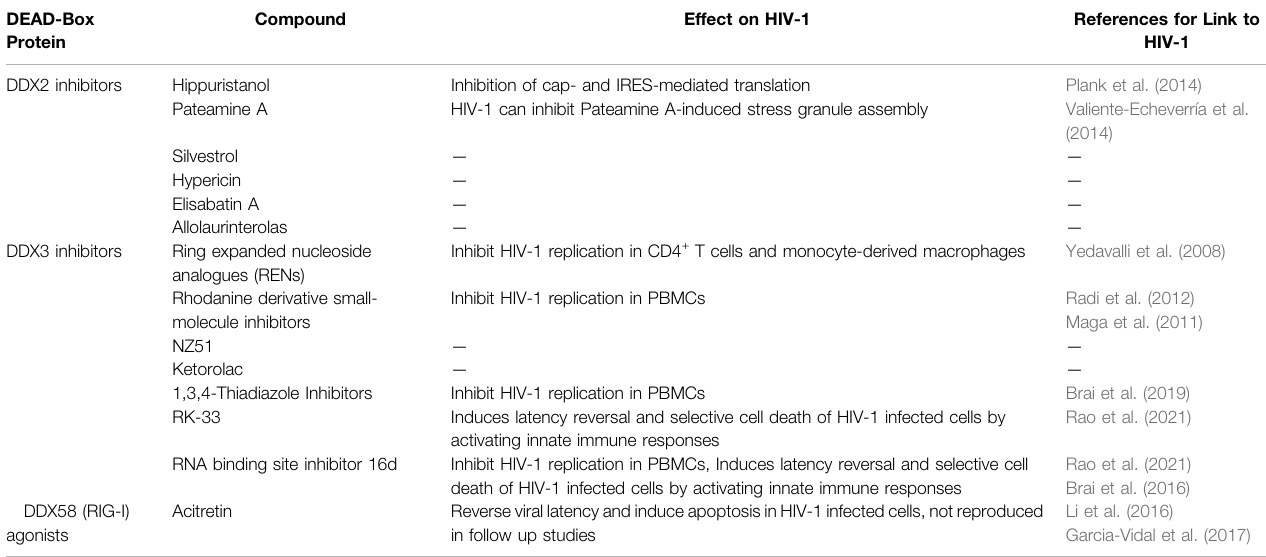
TABLE 2 | List of DEAD-box helicase-directed therapeutics and their demonstrated effect on HIV-1. DEAD-Box Protein